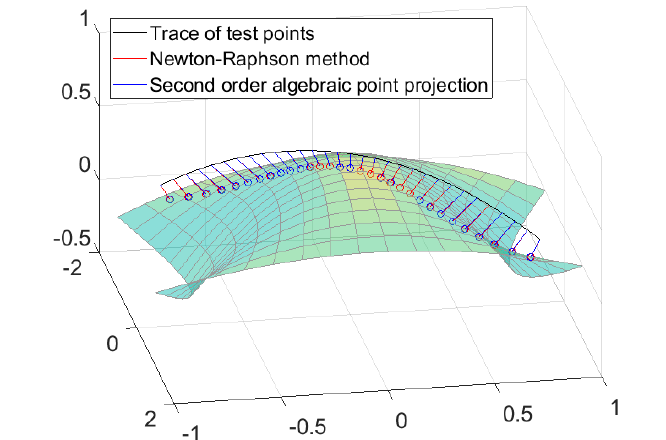
Figure 13. Point projection in 3D physical space using the proposed algebraic method and Newton–Raphson